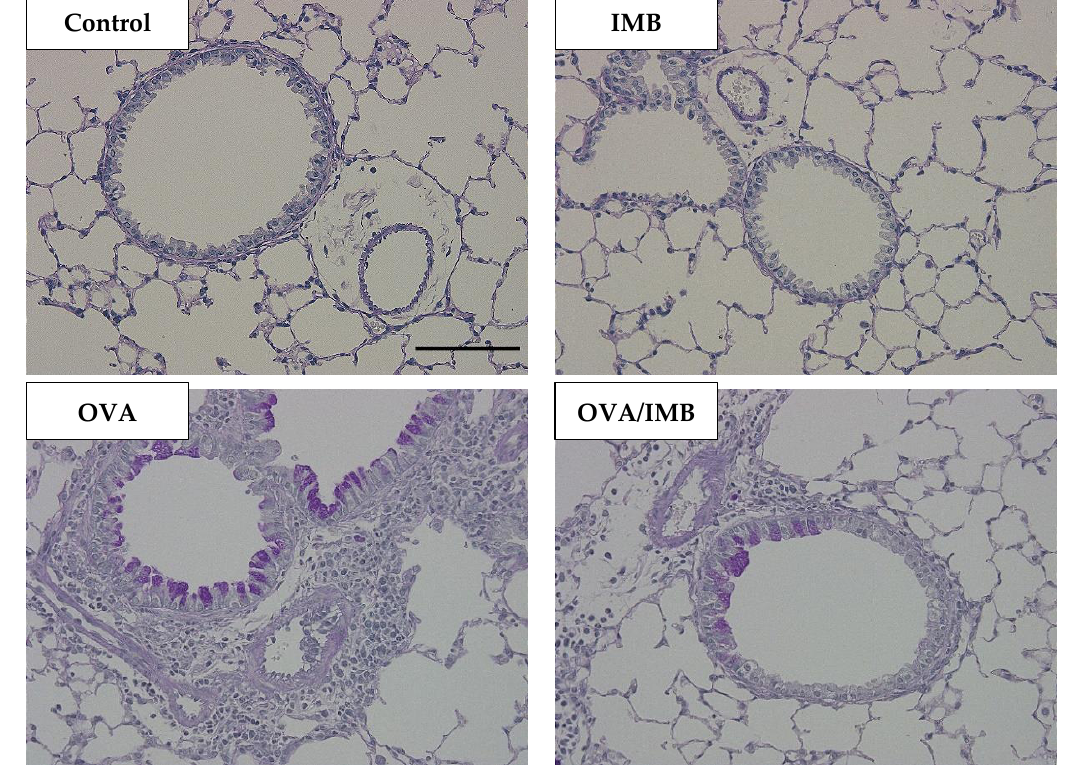
Figure 6. Representative images of lung tissues by HE staining from each group are shown at 200× magnification. Scale bar = 100 µm.